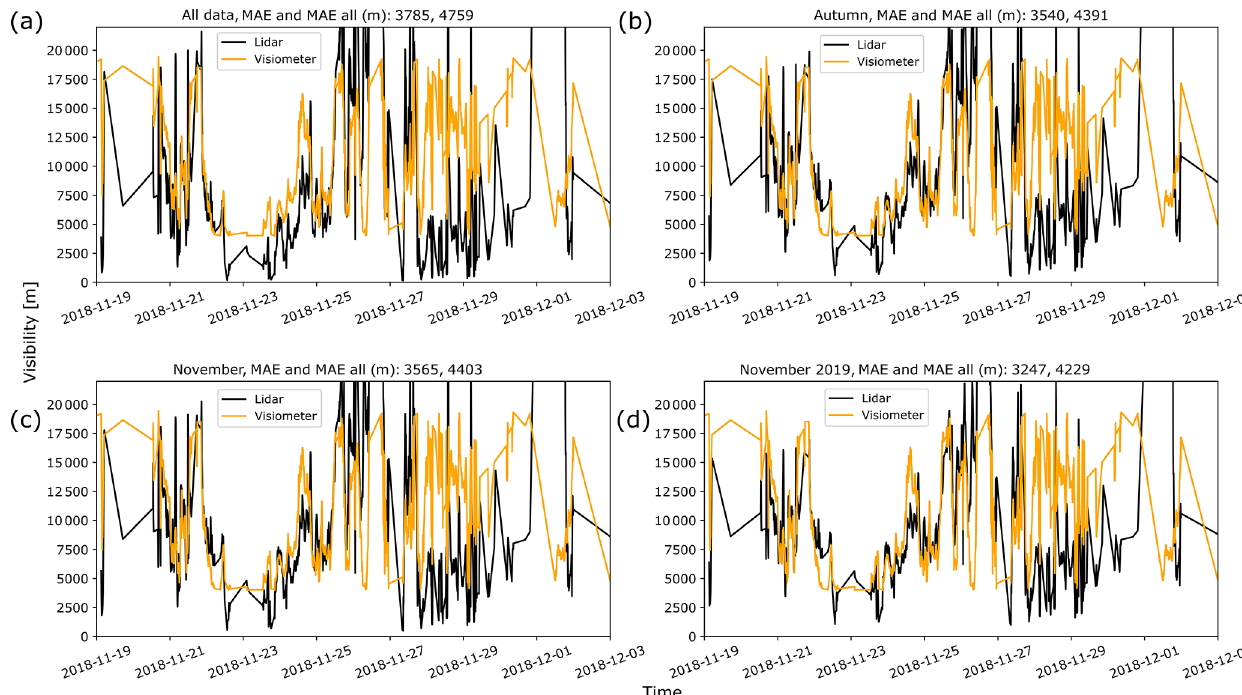
Figure 12. Lidar-derived visibility time series and readings from visiometers for Pershore. Also shown is the mean absolute error (MAE) between the two time series. MAE is for the plotted period only, and MAE all is for whole data period of 24 months. (a) Fit used all data. (b) Fit used autumn data only. (c) Fit used data from Novembers only. (d) Fit used data from November 2019 only. Lidar-derived visibilities outside the [4, 20]km range used for retrieval have been excluded from the calculation of MAE but are plotted to illustrate the effect of extrapolating the transfer function outside that